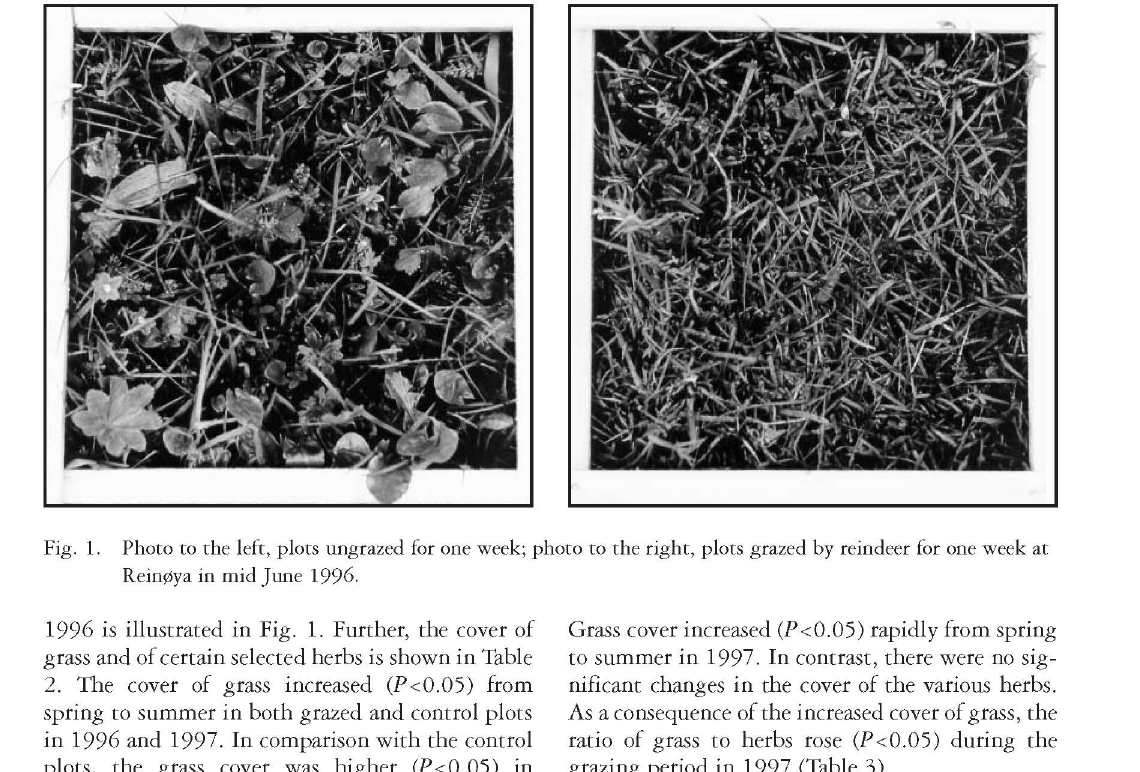
Table 3. Percentage plant cover of grass, Rumex acetosa, Alchemtlla subcrenata, Ranunculus repens, Achillea millefolium , Taraxacum sp. and Equisetum arvense in plots (n=10) grazed by reindeer for 24 days at Reinøya in 1997. Grass: herbs relationship is based on the cover estimates. Different letters in superscript indicates differences (P <0.05) in cover between dates. Standard deviation in